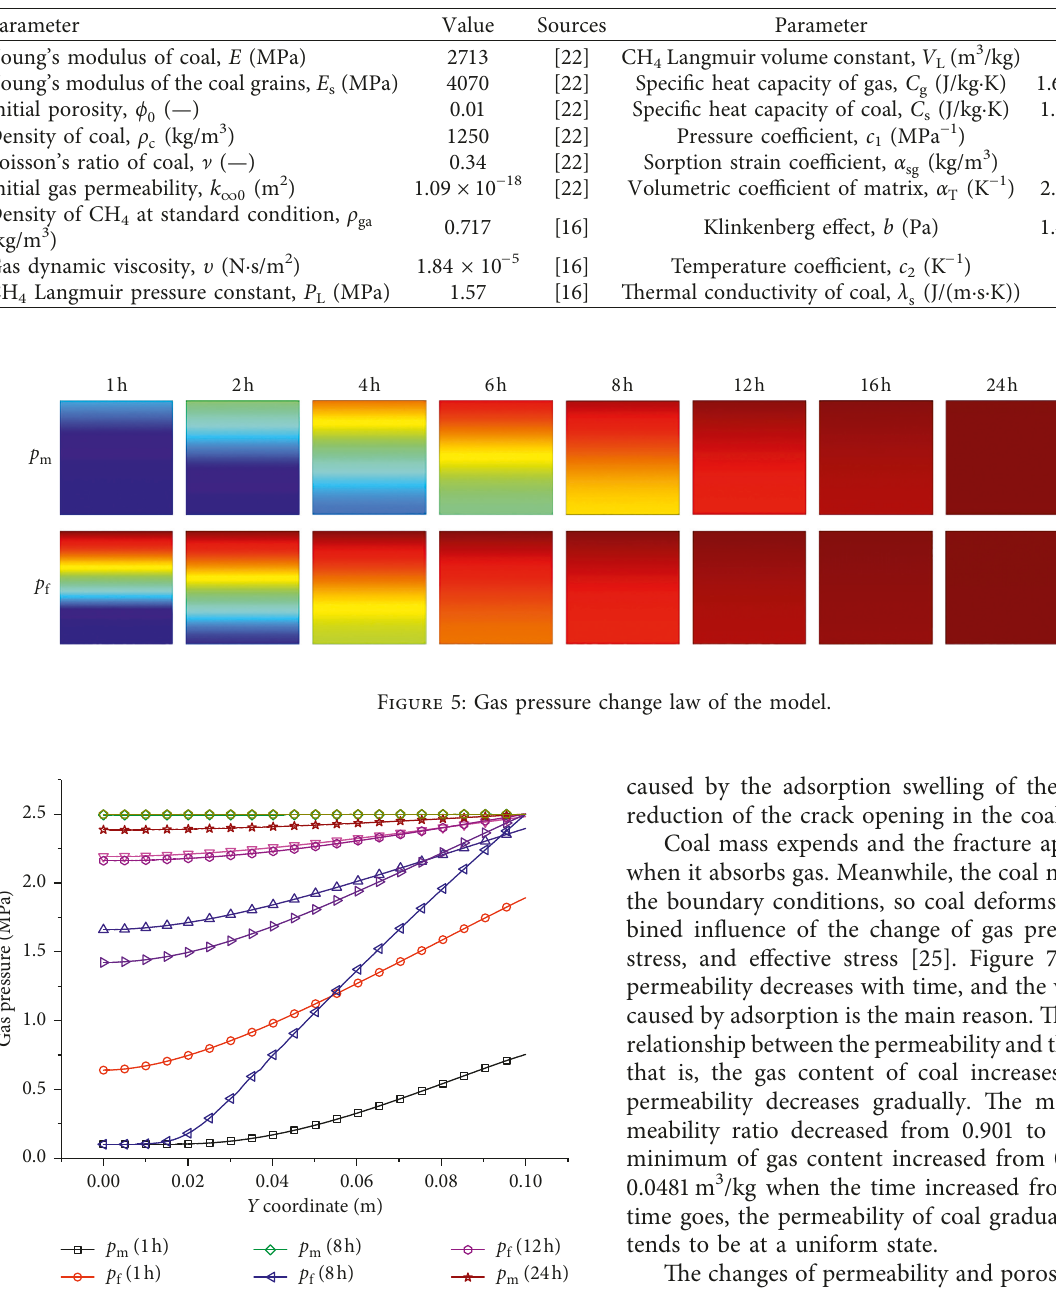
Table 1: Parameters of the model.